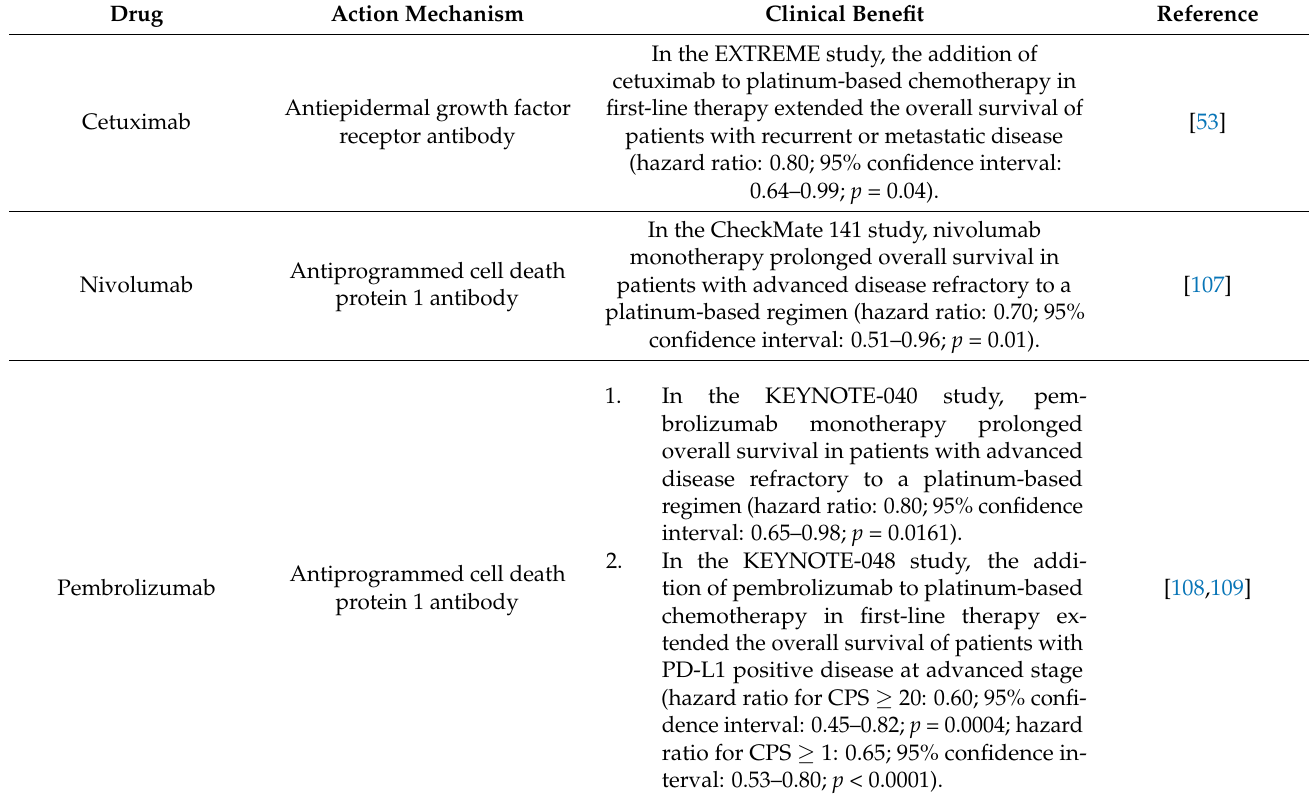
Table 5. Novel anticancer drugs achieving clinical benefits in patients with advanced head and neck cancer (HNC). Drug Clinical